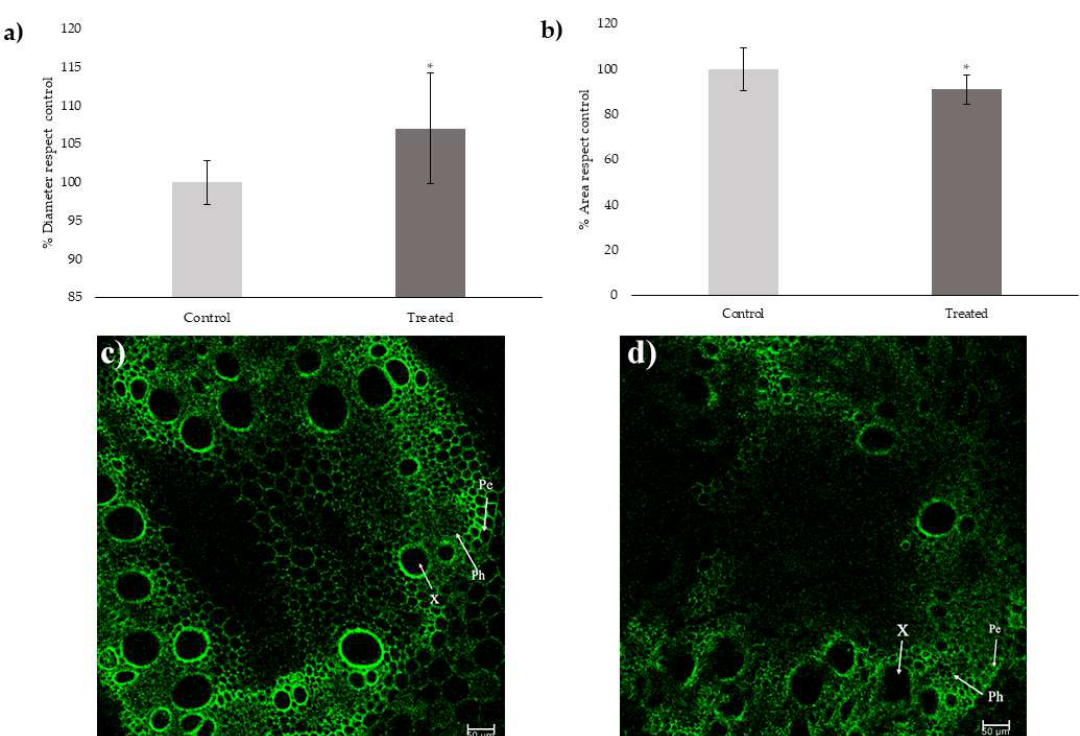
Figure 1. ( a ) Diameter of the vascular bundle after 48 h of treatment with trans -cinnamic acid expressed as a percentage with respect to the control. ( b ) Xylematic area after 48 h of treatment with trans -cinnamic acid expressed as percentage respect to the control. ( c ) Cross section of a maize control root. ( d ) Cross section of a maize trans -cinnamic treated root. (X), xylem; (Ph), phloem; (Pc); pericycle. (*) Indicates significant differences compared to the control (* p ≤ 0.05, ** p ≤ 0.01, *** p ≤ 0.001). Scales bars = 50 μm. Data were analysed with a t -test at p ≤ 0.05.